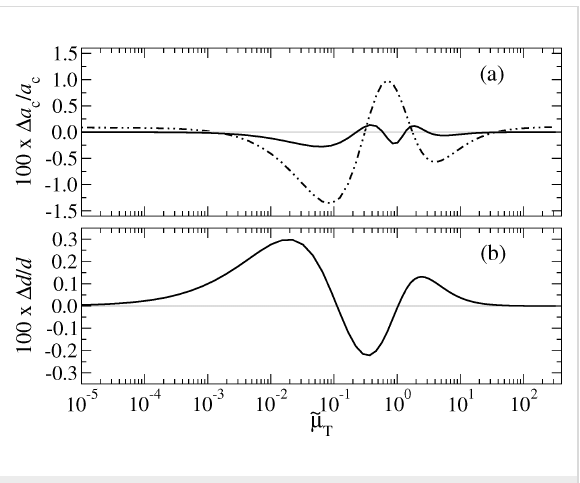
c 1 = 4/5, c 2 = − 1.285, c 3 = 4/5, c 4 = − 0.435, c 5 = − 3/2, c 6 = 0.1845, and c 7 = 6.71.